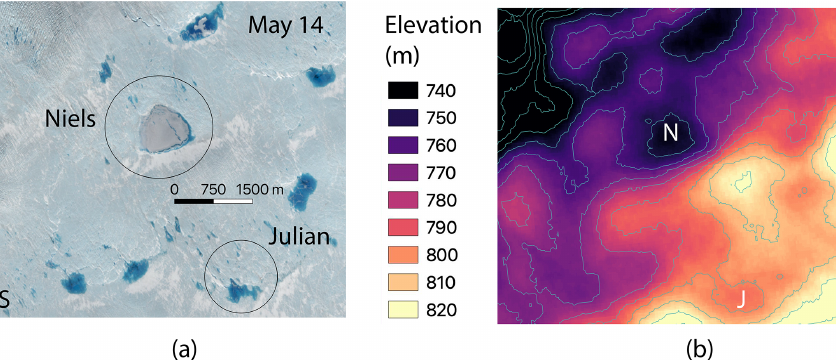
Figure 7. (a) Lake Niels and Lake Julian shown on 14 May 2019 using Sentinel-2 imagery as described in the “Data sources” section. (b) GIMP-2 DEM shown at same location with contours shown at 10m intervals.